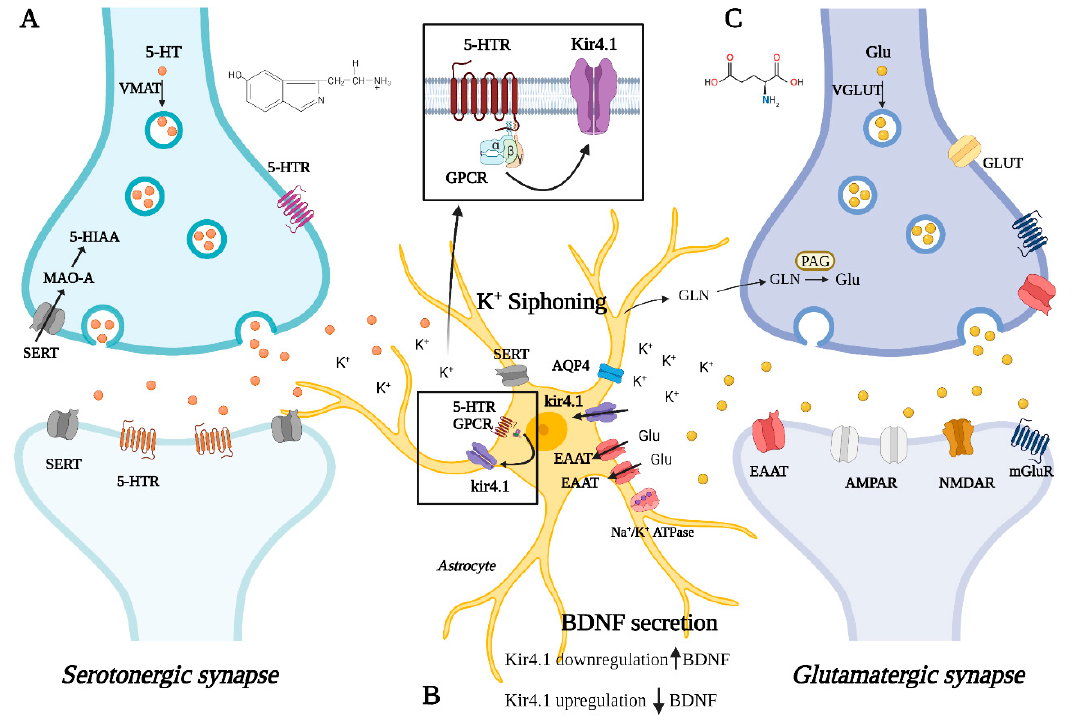
Figure 2. Graphical representation of a tripartite synapse where the following neurometabolic pathways involved in depression and possibly affected by Kir4.1 dysfunction are schematically illustrated: ( A ) Serotonergic transmission ( B ) astrocyte-mediated K + siphoning, glutamate reuptake, and BDNF secretion ( C ) glutamatergic transmission.